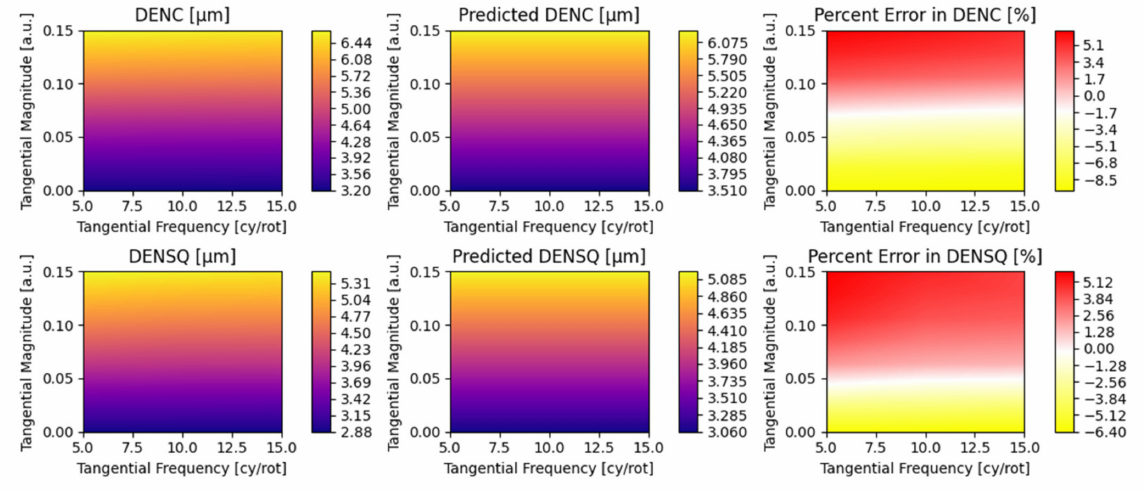
Figure A19. Tangential Frequency vs. tangential magnitude. ( η = ζ = δ = 0, ξ = 15, σ = 0.05, θ = 30 ◦